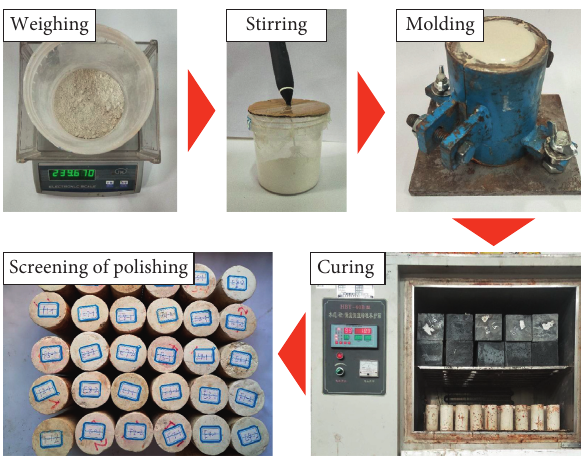
Figure 3: Sample preparation